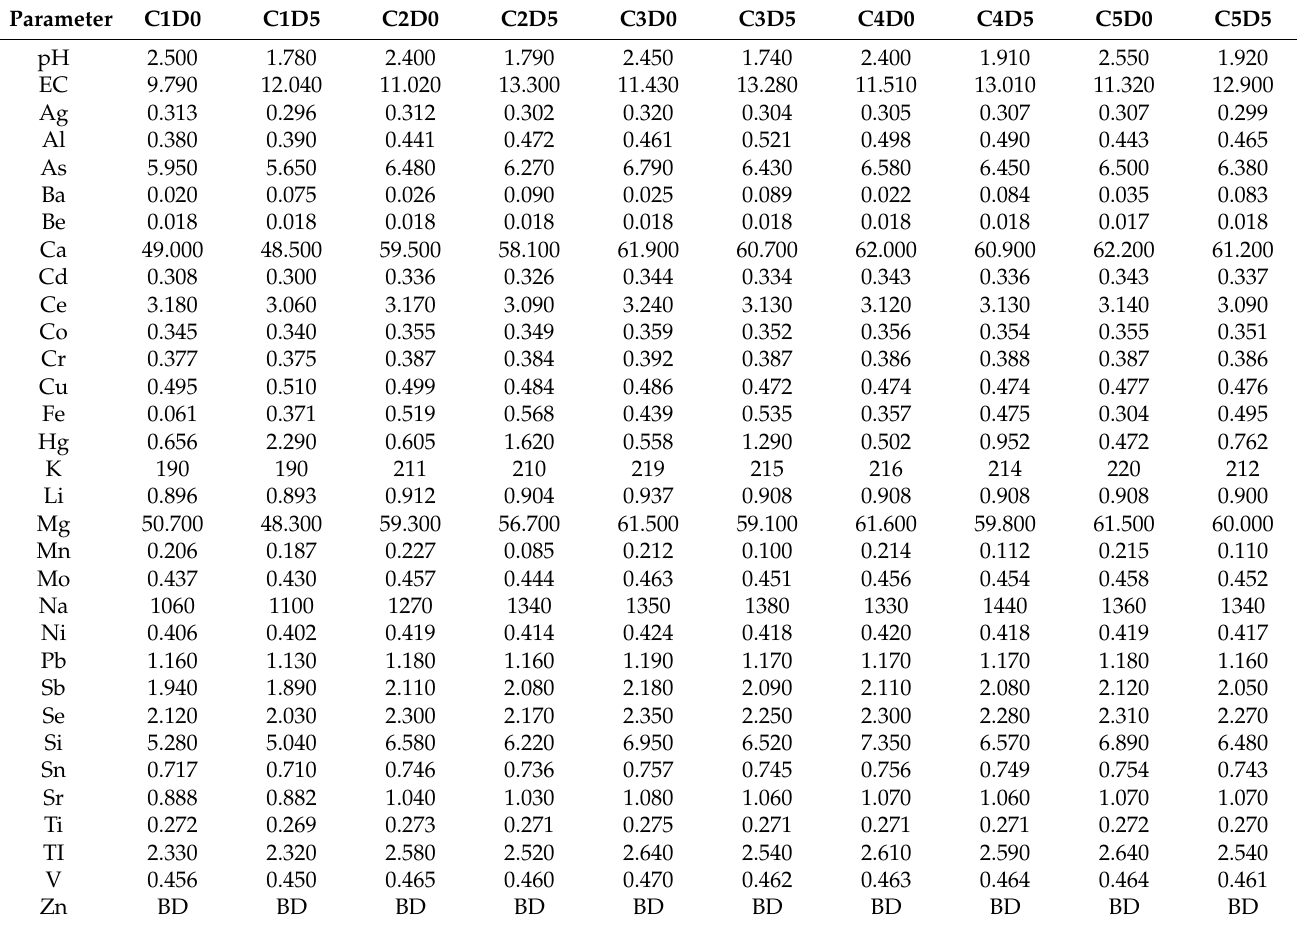
Table 4. Characteristics of the landfill leachate sample at the beginning and at the end of each growth cycle. Values represent the average of n = 3